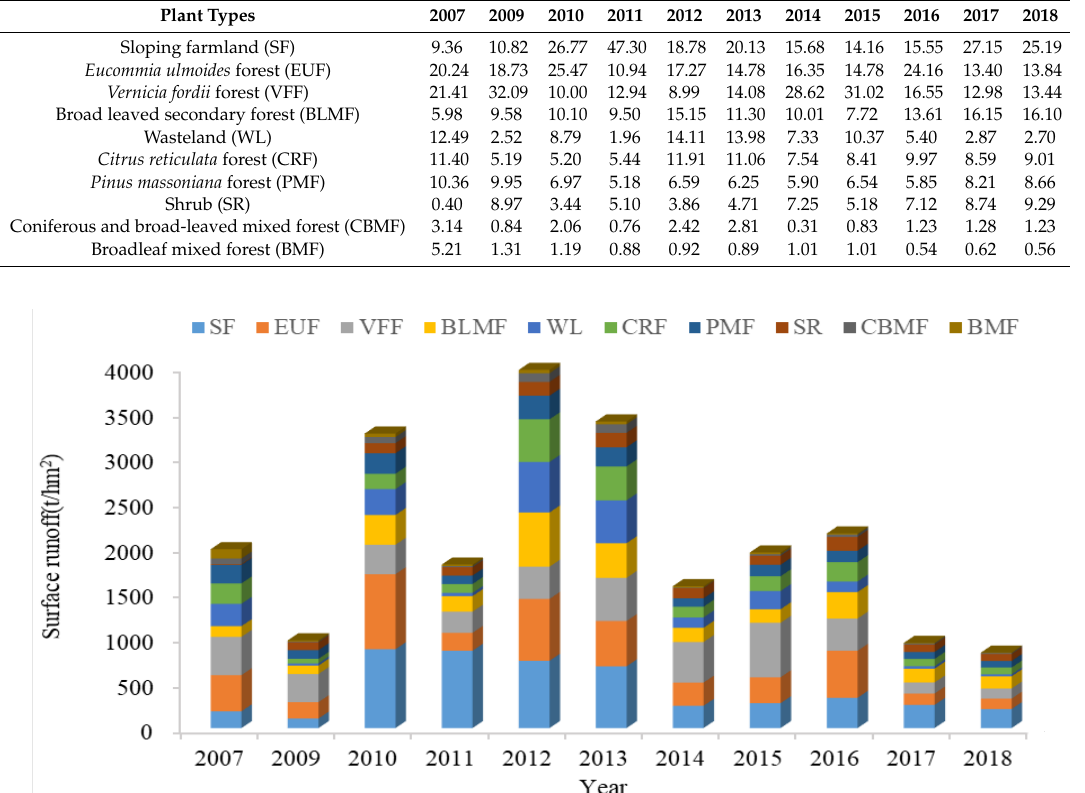
Figure 6. Percentage (%) of vegetation types from 2007 to 2018.